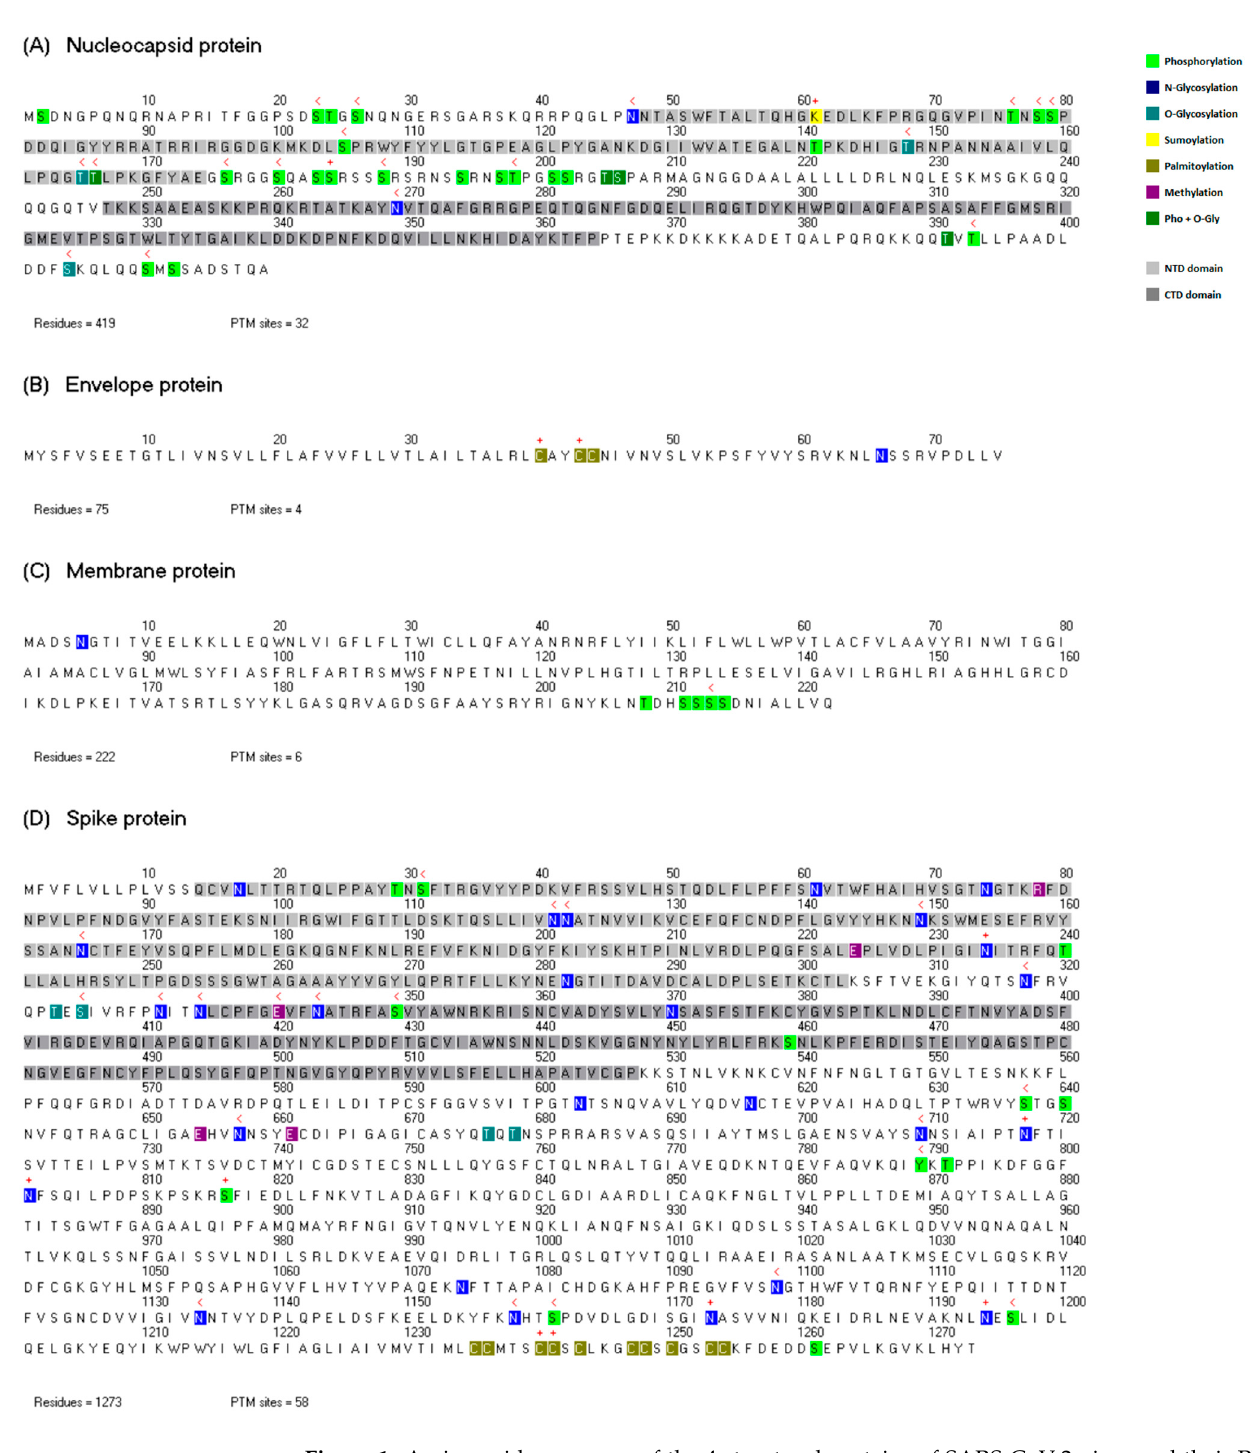
Figure 1. Amino acid sequences of the 4 structural proteins of SARS-CoV-2 virus and their PTM sites. The functional domains and the PTM sites are represented in different colors as indicated at the top right of the Figure. The nucleocapsid protein contains 4 multiPTM sites (depicted in dark green), which are sites with different types of PTMs observed at the same position, in this case phosphorylations and O-glycosylations. The residues labeled with a “+” symbol correspond to the PTM sites with the highest degree of conservation (see Section 3.1), and the residues labeled with a “<” symbol correspond to the PTM sites with the lowest mutation frequency (see Section 3.2).